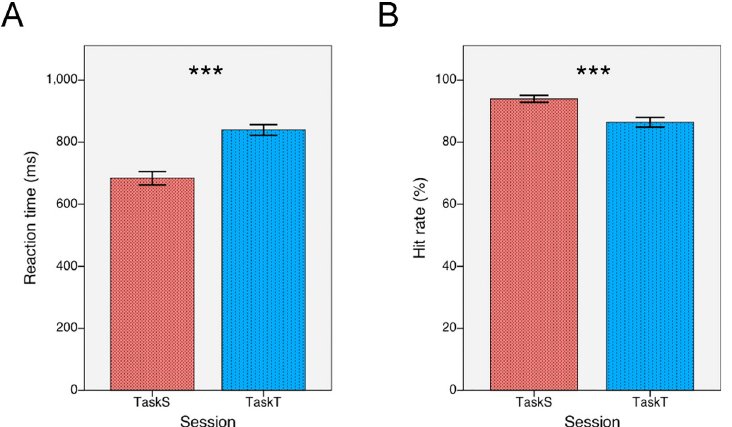
Fig 2. Behavioral performance. (A) The reaction time was significantly earlier for TaskS than for TaskT. (B) The hit rate was significantly higher for TaskS than for TaskT. Behavioral performance suggests that subjects detected structural features of Chinese characters faster and more accurately than tonal features when they focused their attention on the corresponding features. Error bars refer to ±